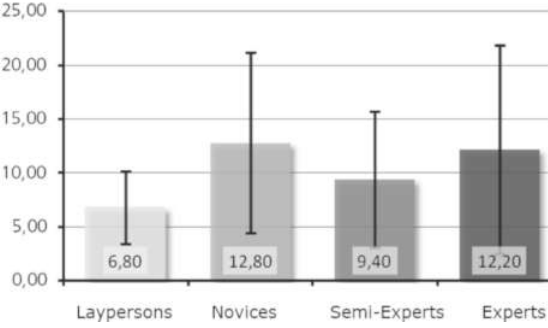
Figure 6. Number of fixated basic features (Moses).